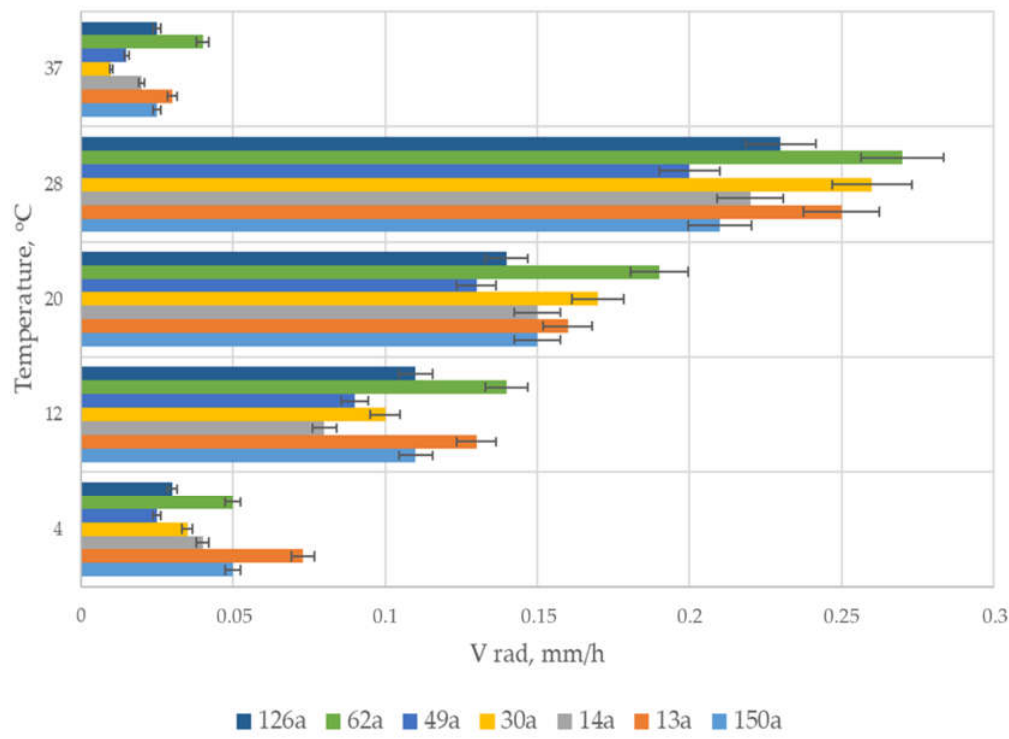
Figure 2. Radial-growth-rate determination of Tolypocladium strains obtained from White Sea